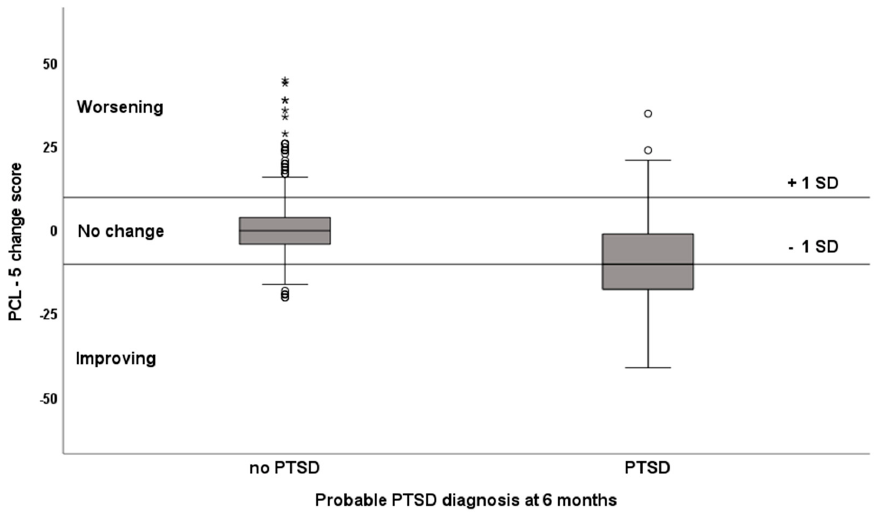
Figure 2. Boxplots of PCL-5 change scores differentiated for probable PTSD 6 months post-injury. The boxplots demonstrate the interquartile range and median of the PCL-5 change scores for participants with and without probable PTSD at 6 months. The whiskers represent 1.5 × IQ range, ◦ are outliers between 1.5 and 3 × IQ range, * are outliers over 3 × IQ range.